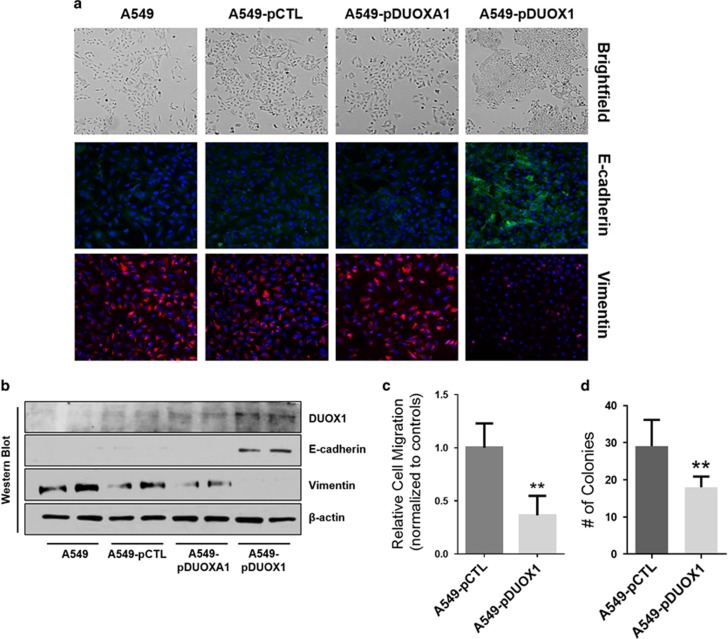
Overexpression of DUOX1 in A549 cells promotes epithelial signatures. (a) Brightfield microscopy reveals DUOX1-overexpressing cells display an epithelial cell morphology. Confocal imaging of epithelial marker E-cadherin and mesenchymal protein vimentin. (b) Western blot analysis shows DUOX1 overexpression promotes features of the mesenchymal-to-epithelial transition. (c) Donut cell migration assay displaying slower migration in DUOX1-overexpressing cells. (d) DUOX1 overexpression inhibits colony formation on soft agar. **P<0.01 was calculated by Student's t-test.